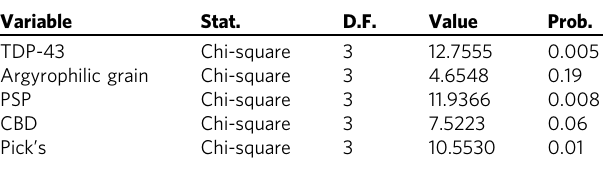
genotype and pathology. Variable